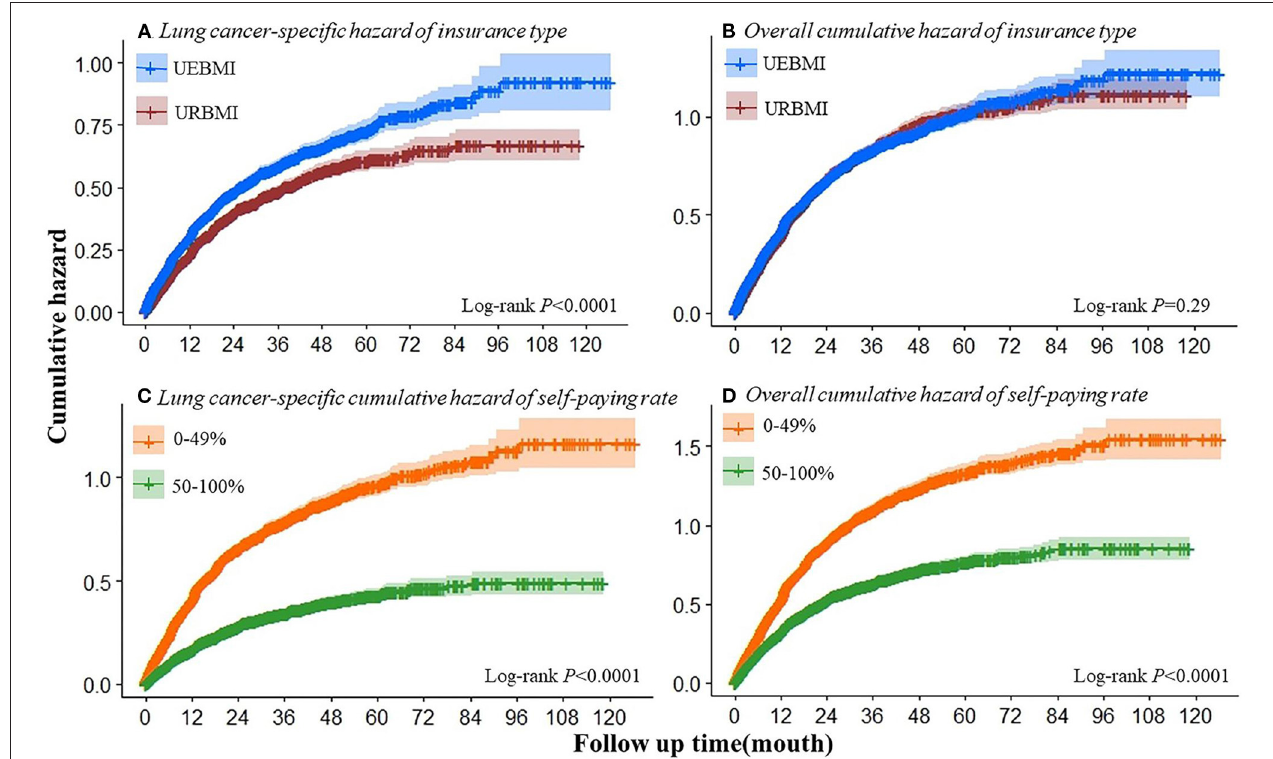
FIGURE 1 | Cumulative hazard of cancer-specific or overall mortality by insurance type (A,B) and self-paying rate (C,D) .